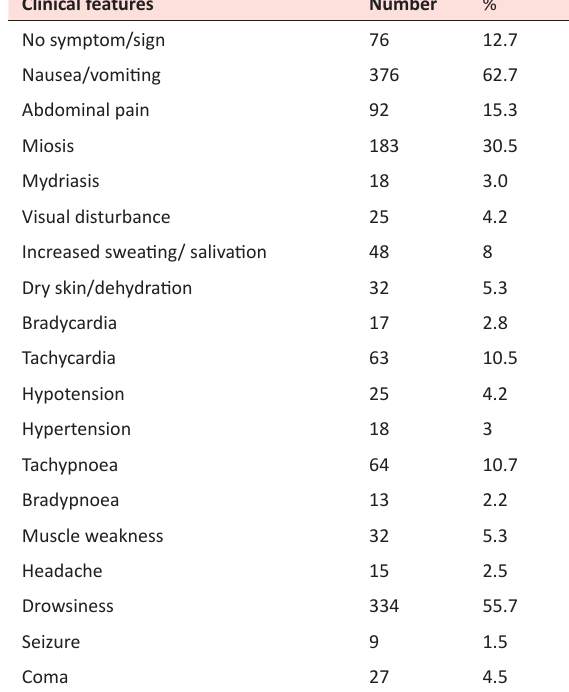
Table 3. Clinical features of the poisoning cases (n =